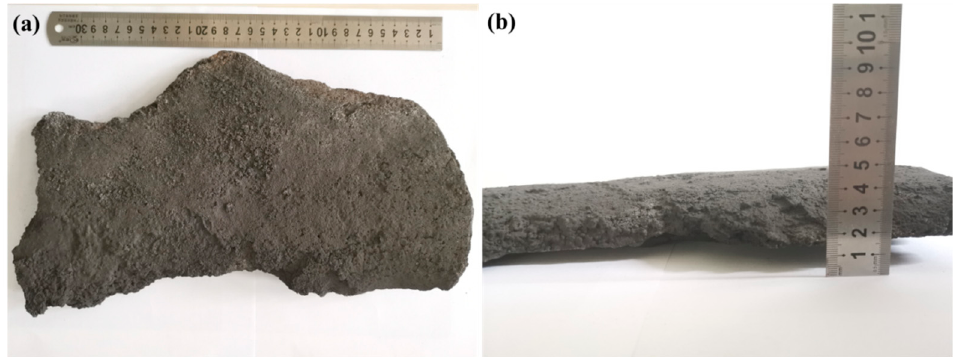
Figure 1. Dimensions of the bulk sample: ( a ) length and width; ( b ) thickness.